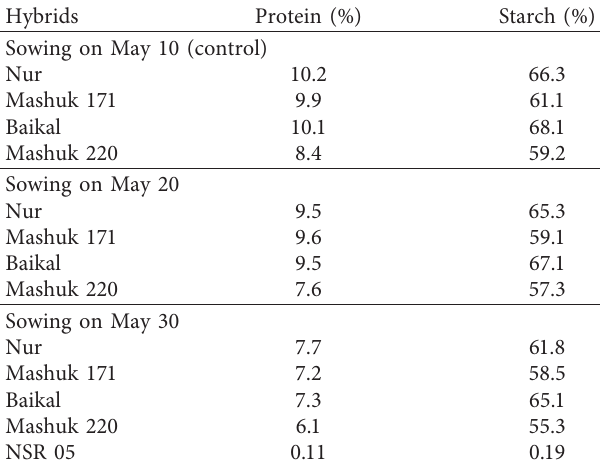
Table 2: The quality of maize hybrids sown at different sowing